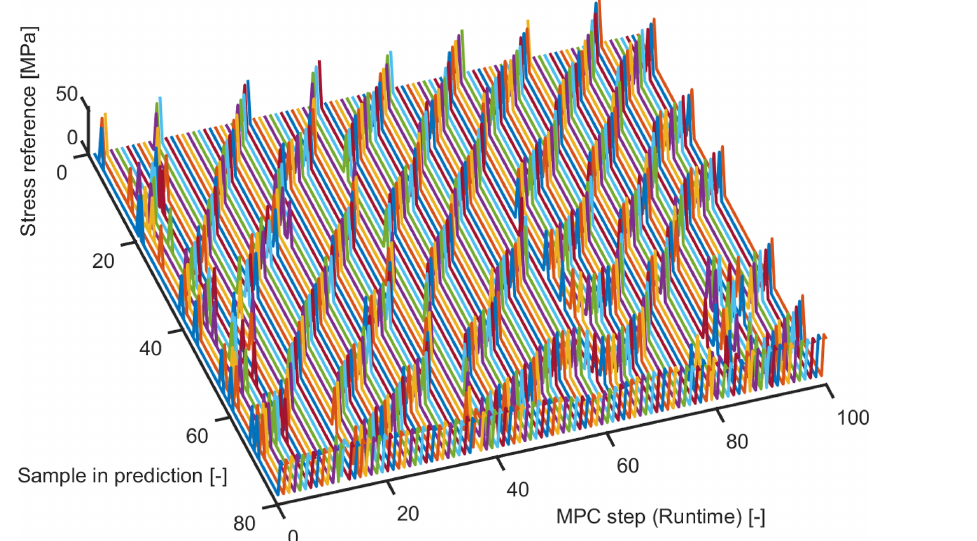
Figure 16. PORFC stress reference over the prediction horizon of 80 samples for 100 consecutive MPC